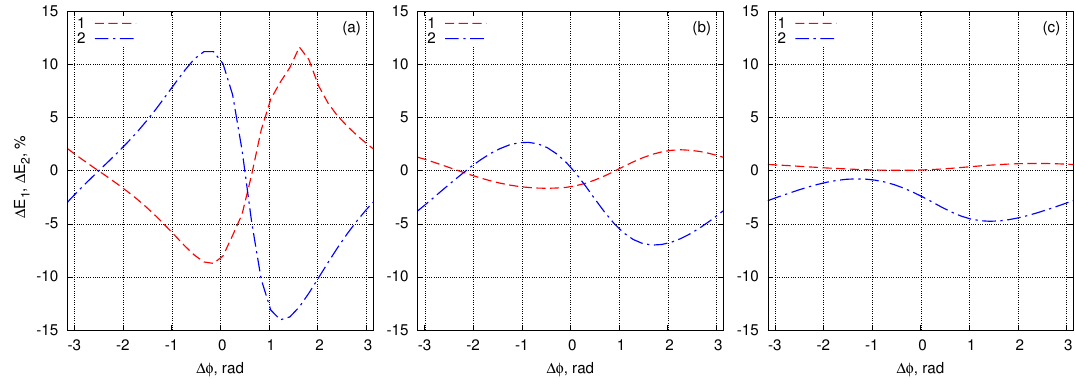
Figure 10. The individual energy change (in percent—see Formula (41)) of breathers after their collision depending on the relative phase ∆ φ in experiment 3 . The dashed red curve 1 shows dependence of the energy change for the left breather ∆ E 1 ( ∆ φ ) while the blue dash-dotted curve 2 corresponds to dependence of the energy change for the right breather ∆ E 2 ( ∆ φ ) . Panels ( a – c ) correspond to the three different values of the relative velocities of the breathers in ascending order.